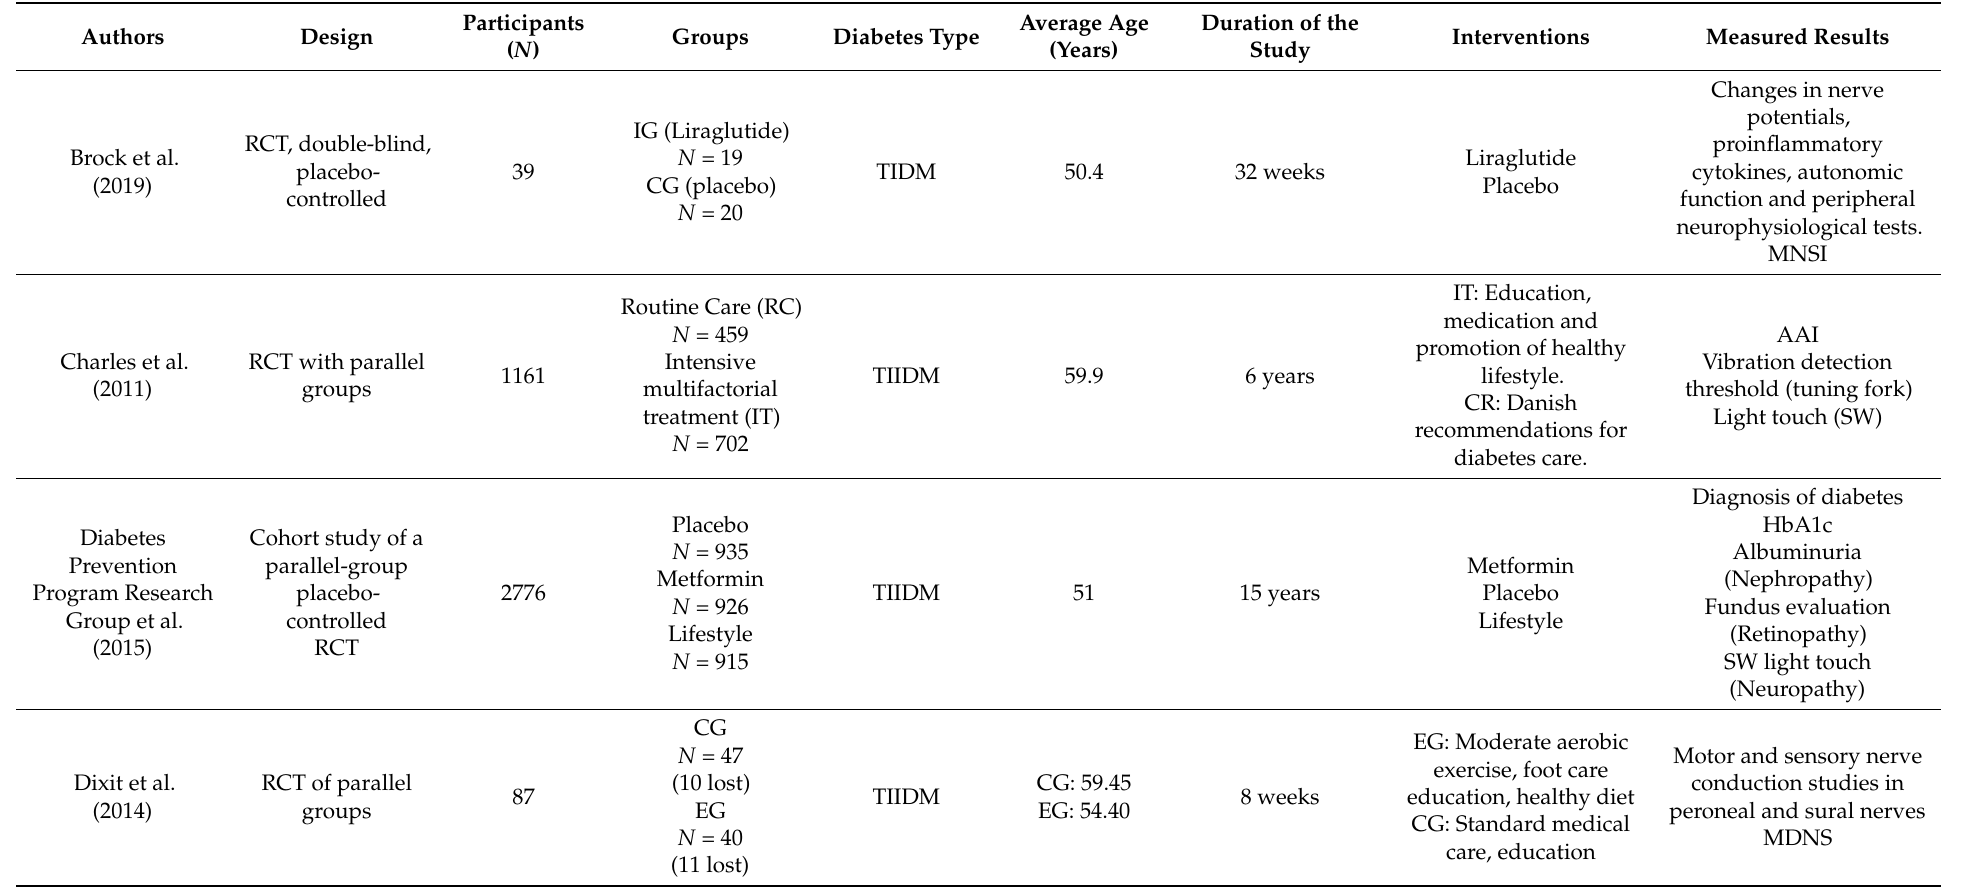
Table 5. Main characteristics of the studies